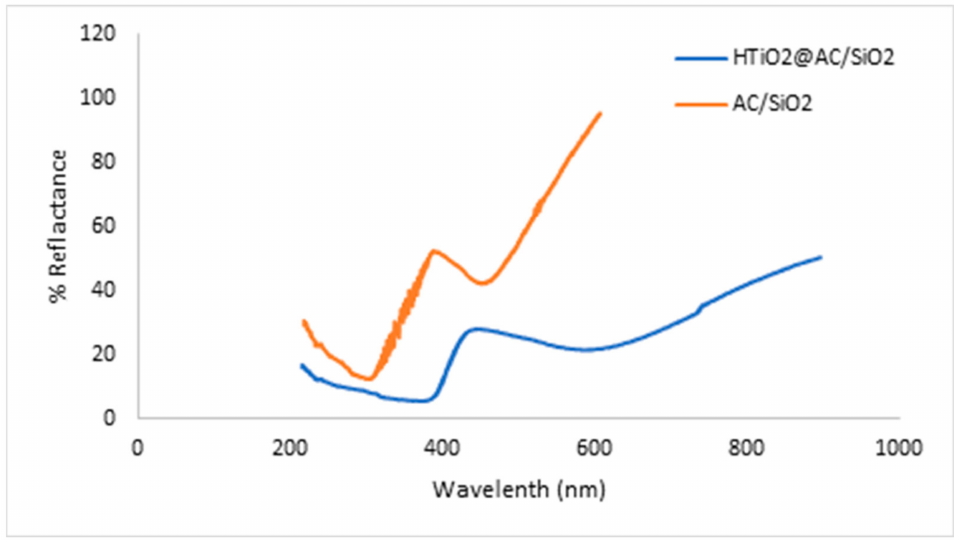
Figure 5. The reflectance